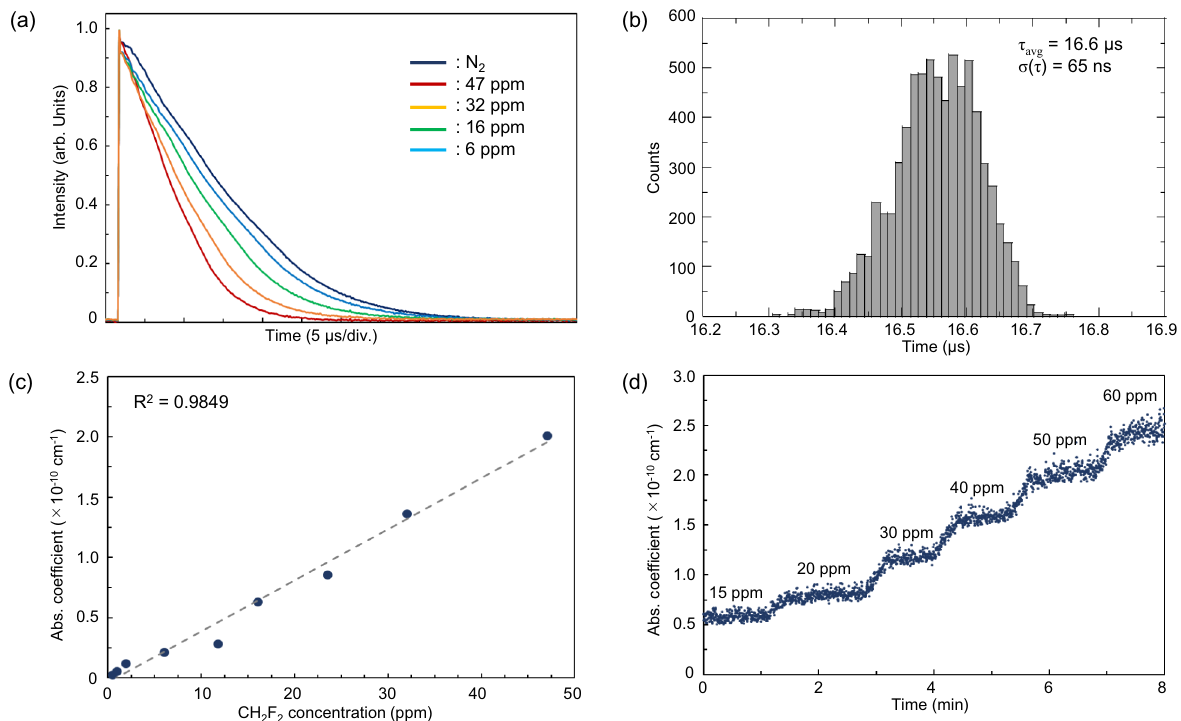
Figure 4. CH 2 F 2 detection using CRDS with the ET-Cr:ZnSe laser. ( a ) RDTs under changing CH 2 F 2 concentrations. Each RDT was obtained by averaging 32 ring-down events. ( b ) Histogram of the RDTs in the N 2 -purged RDC. In total, 7300 ring-down events were used. ( c ) Linear regression plot between the CH 2 F 2 concentration and the absorption coefficient. Each RDT was obtained by averaging 32 ring-down events. ( d ) Continuous measurement results with cascading CH 2 F 2 concentration